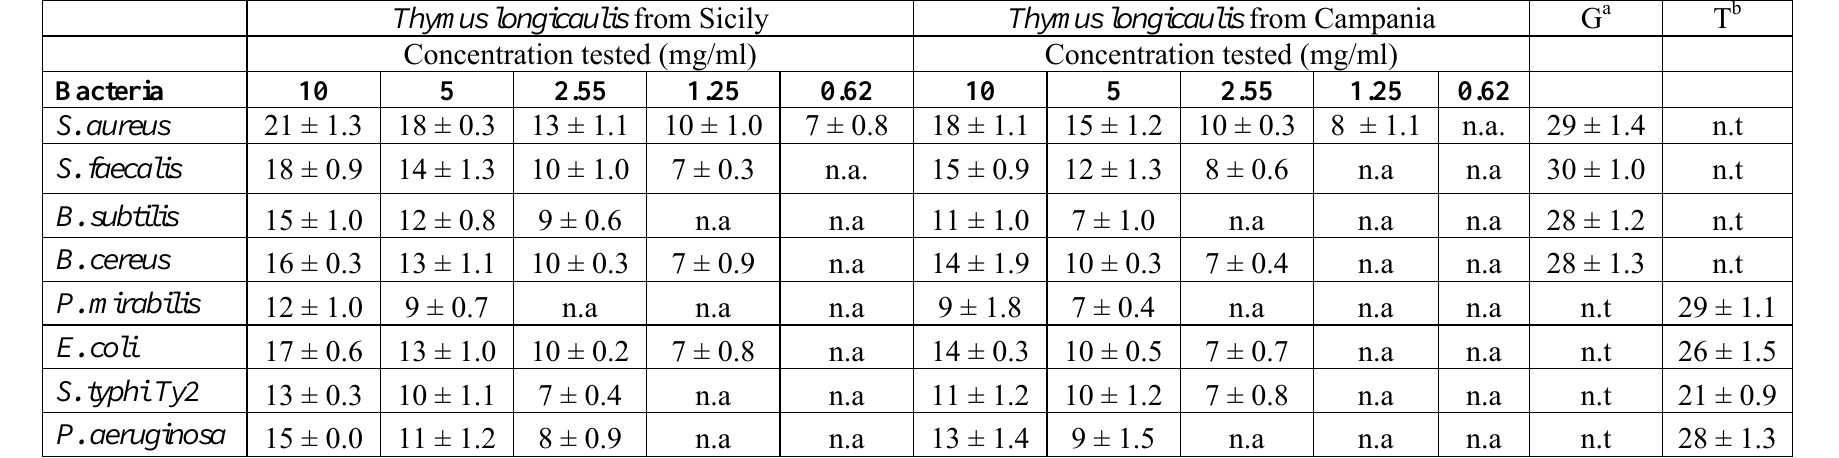
Table 2a. Antibacterial activity (diffusion method) of different amounts of the essential oil of T. longicaulis . Inhibition is expressed in mm and include the diameter of paper disc (6 mm). Results are shown as mean ± standard deviation (SD) of the inhibition zone (n = 3).